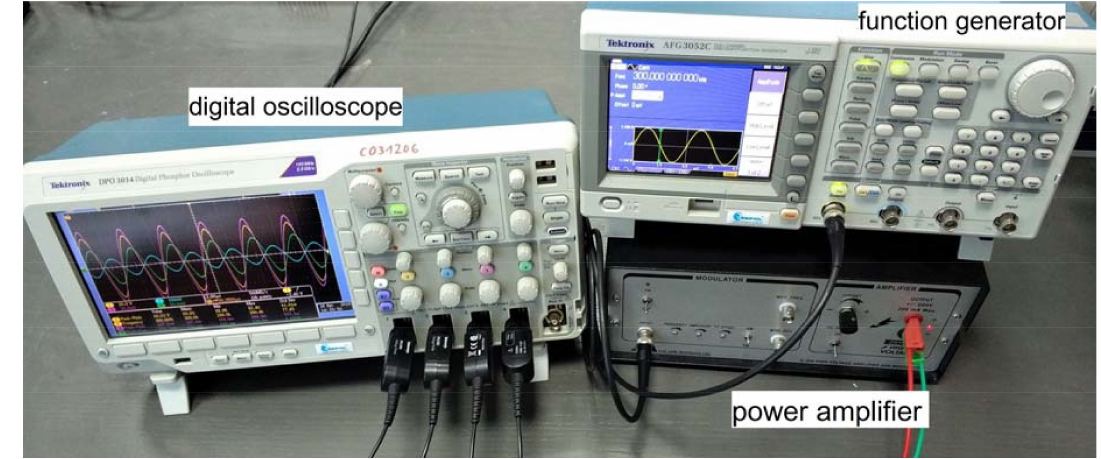
Figure 7. The system devices prepared for